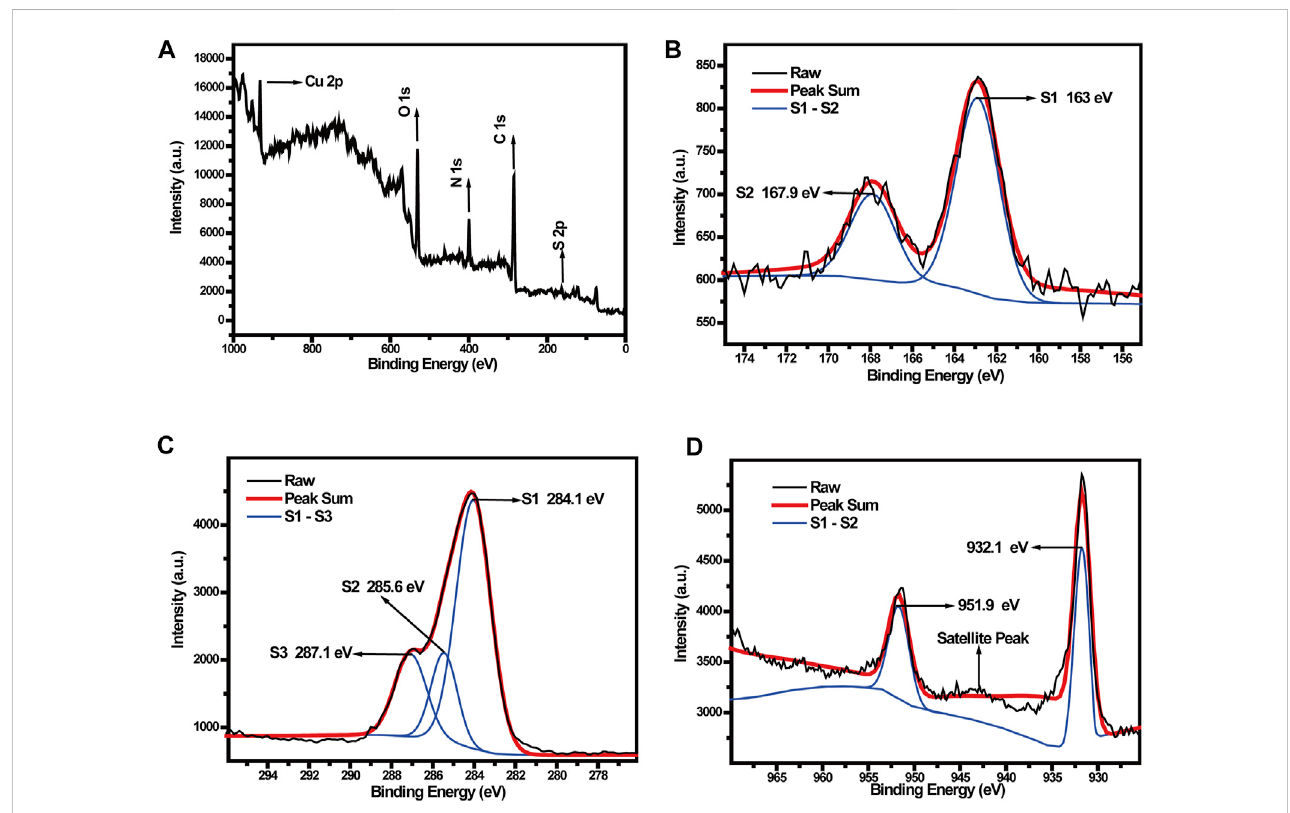
FIGURE 3 (A) XPS survey spectra and (B) S, (C) C, (D) Cu element XPS spectrum of